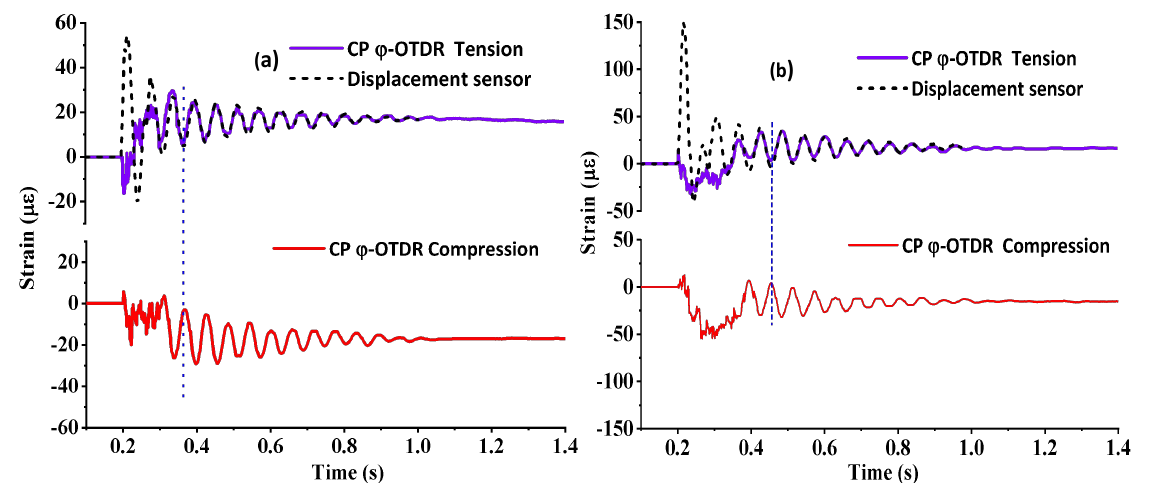
Figure 6. Strain–time response comparison between the CP ϕ − OTDR and linear potentiometer (LP) at midspan with different drop heights of ( a ) 10 mm and ( b ) 40 mm.